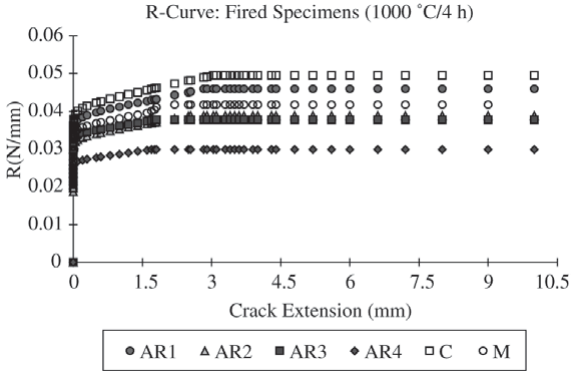
Figure 3. R-Curve of unfired specimens with different composi- tions and coarse aggregate aspect